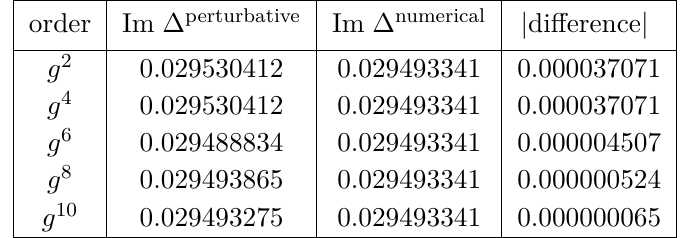
Table 2 . Comparison between the 5-loop analytic weak coupling prediction and the numerical data for the anomalous dimension at g = 0 . 1 with κ = e i and ˆ κ = e i/ (1+ ζ 3 )